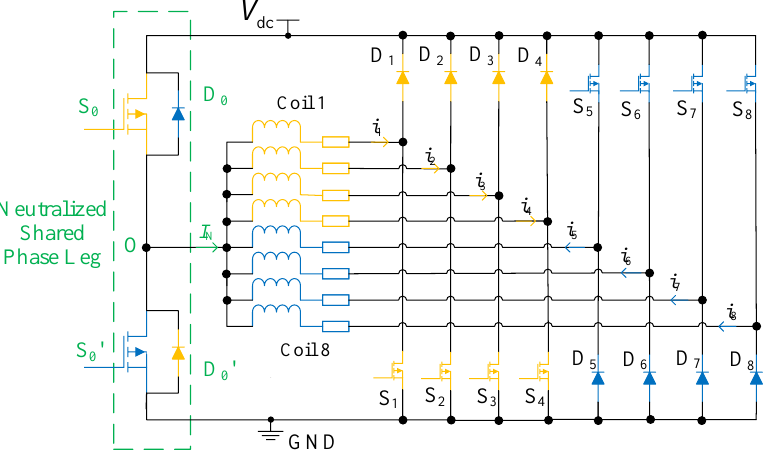
Figure 9. Neutralized-sharing-bridge topology of the SPA for the four DOF AMB.